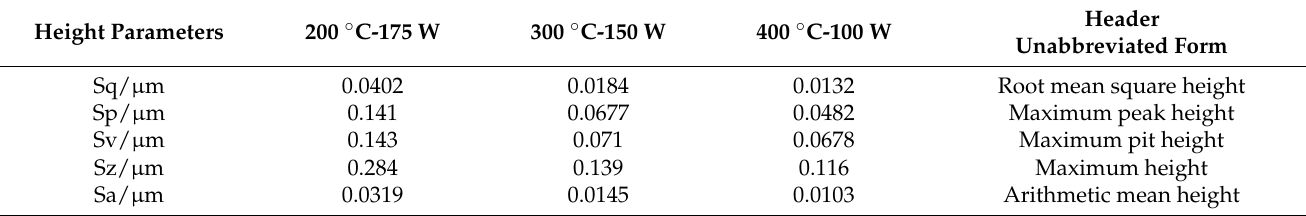
Figure 5. The 3D profile of the Ta coatings. ( a ) 200 °C-175 W, ( b ) 300 °C-150 W, and ( c ) 400 °C-100 W. Table 3. Height parameters of the Ta coatings in different conditions. Table 3. Height parameters of the Ta coatings in different conditions.